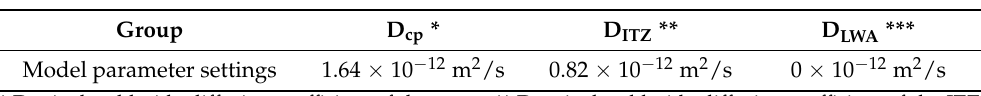
Table 6. Groups of global model parameters. Table 7. Random aggregate model parameter settings.